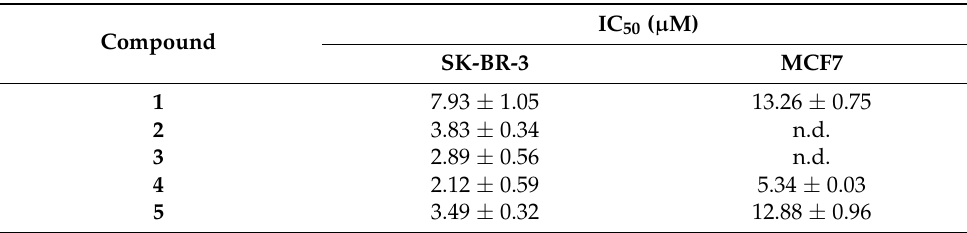
Table 1. Growth inhibition efficiency (IC 50 ) of betulin ( 1 ) and its derivatives on two breast cancer cell lines after treatment for 72h; table shows arithmetic means ±